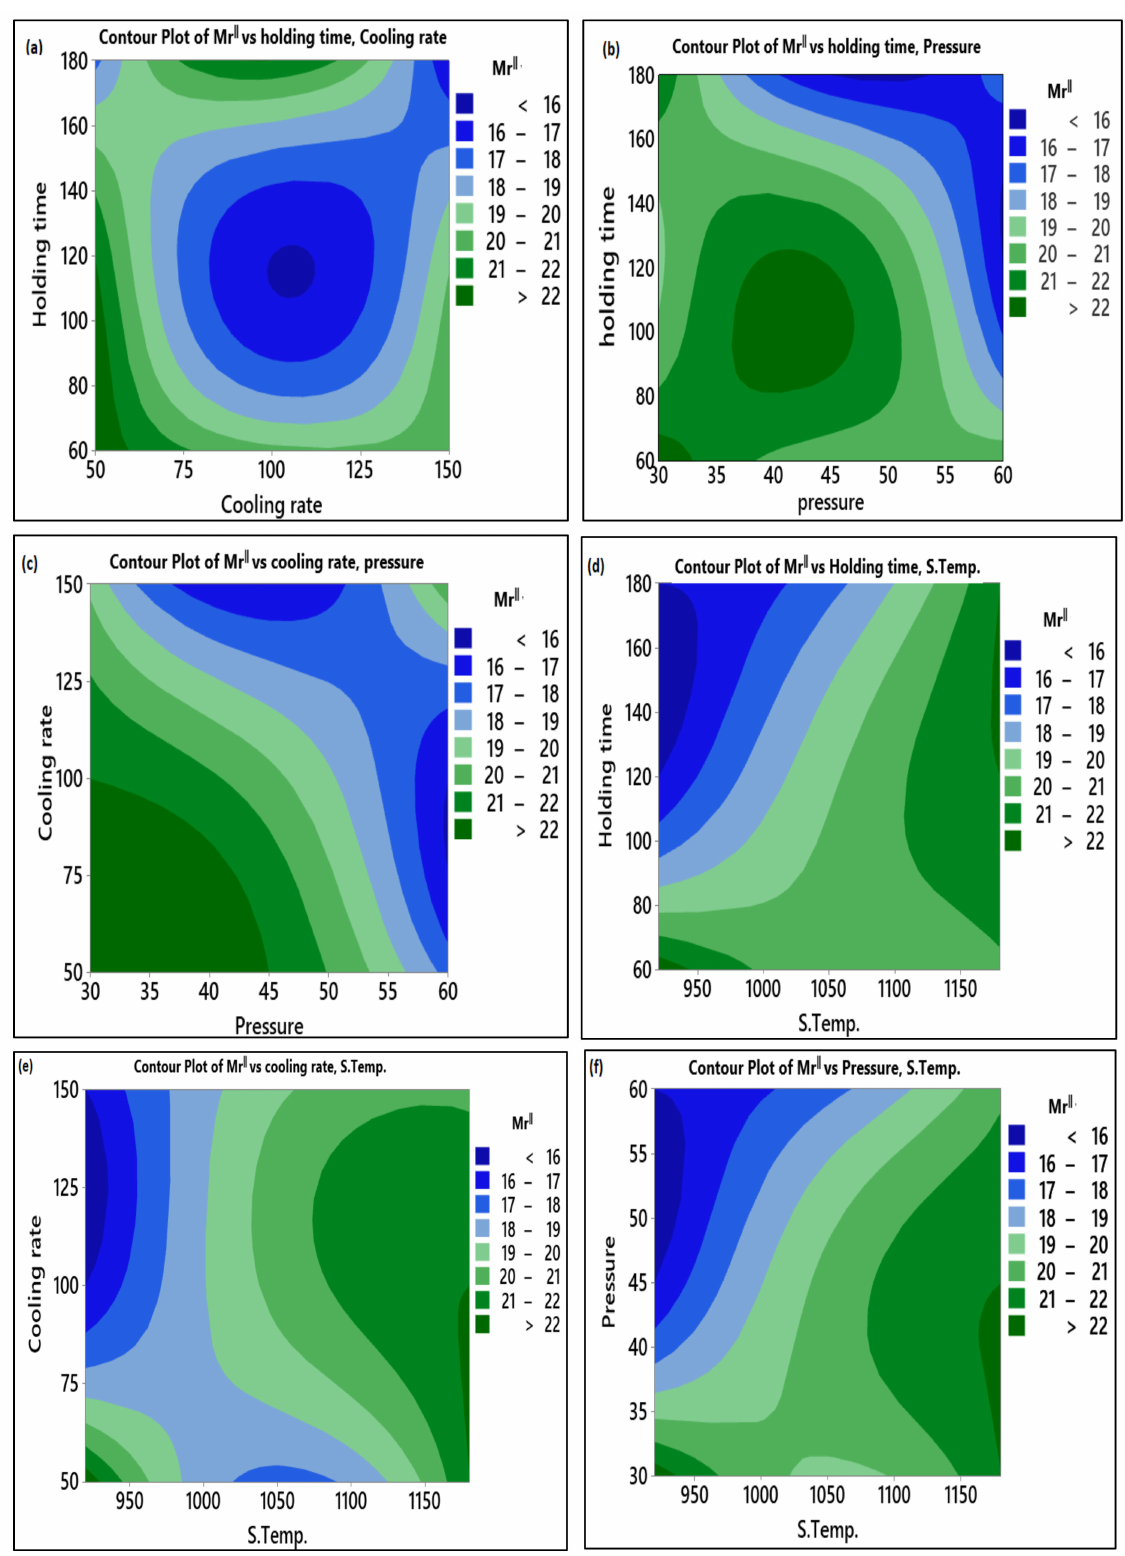
Figure 10. Contour plot for Mr (cid:107) : ( a ) Holding time vs. cooling rate; ( b ) Holding time vs. pressure; ( c ) Cooling rate vs. pressure; ( d ) Holding time vs. S. temp.; ( e ) Cooling rate vs. S. temp.; ( f ) Pressure vs. S.